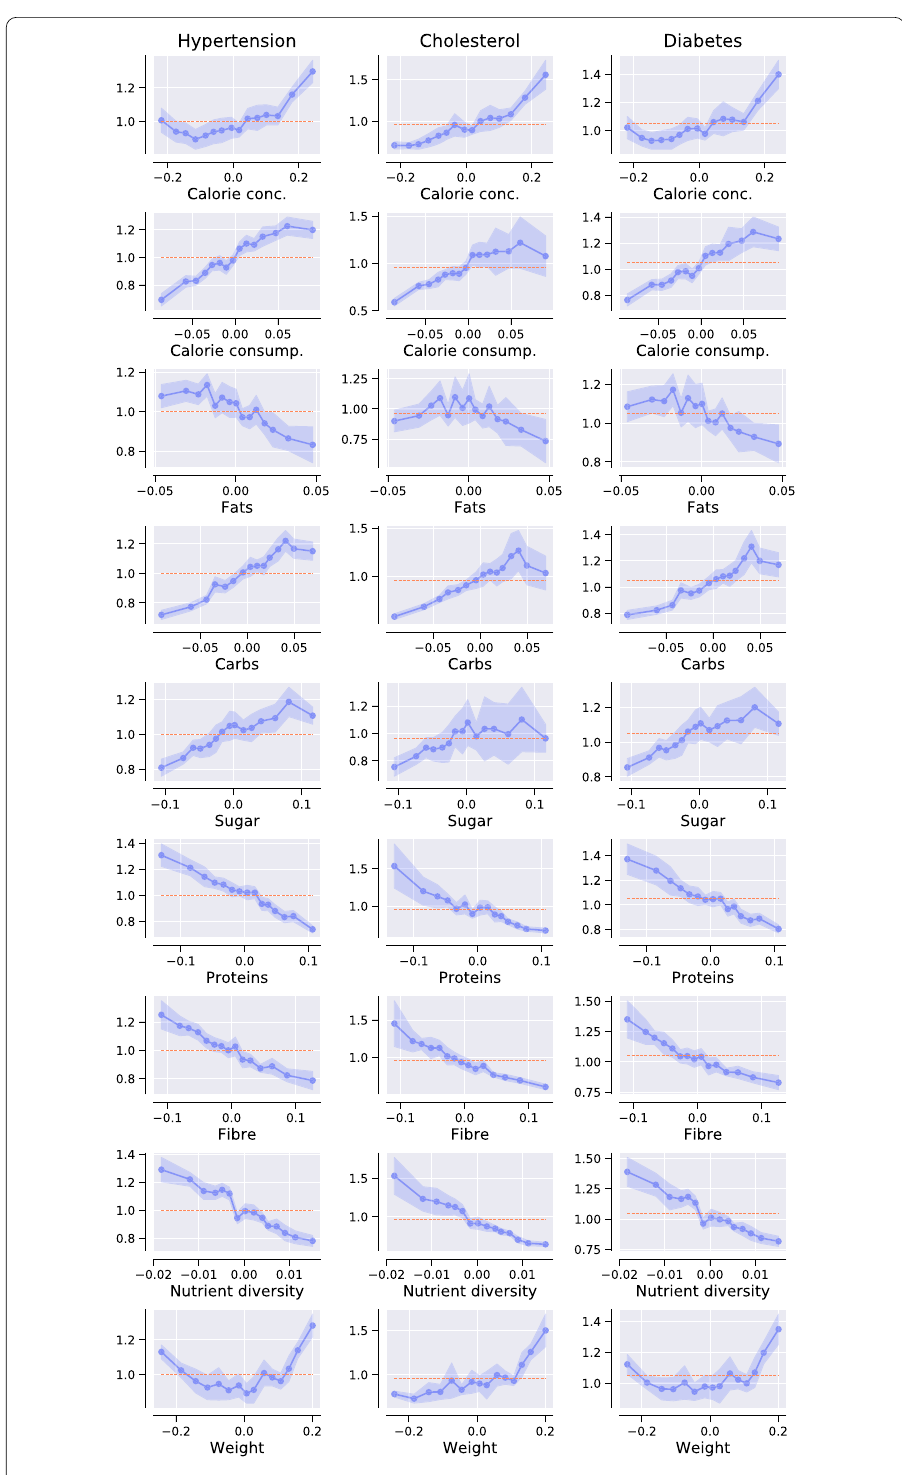
Figure 4 The relationship between hypertension, cholesterol, and diabetes (columns) and food-related metrics (rows). On the x -axis, we represent the relative food-consumption values compared to the average (set at 0), which are computed with Formula (9). On the y -axis, we represent the per-capita disease prevalence, which is computed with Formula (1): a value of 1 for a disease means that each resident takes, on average, 1 medication for that disease in the year. The dotted red line indicates the average disease prevalence across all areas. The shaded areas show 95% confidence